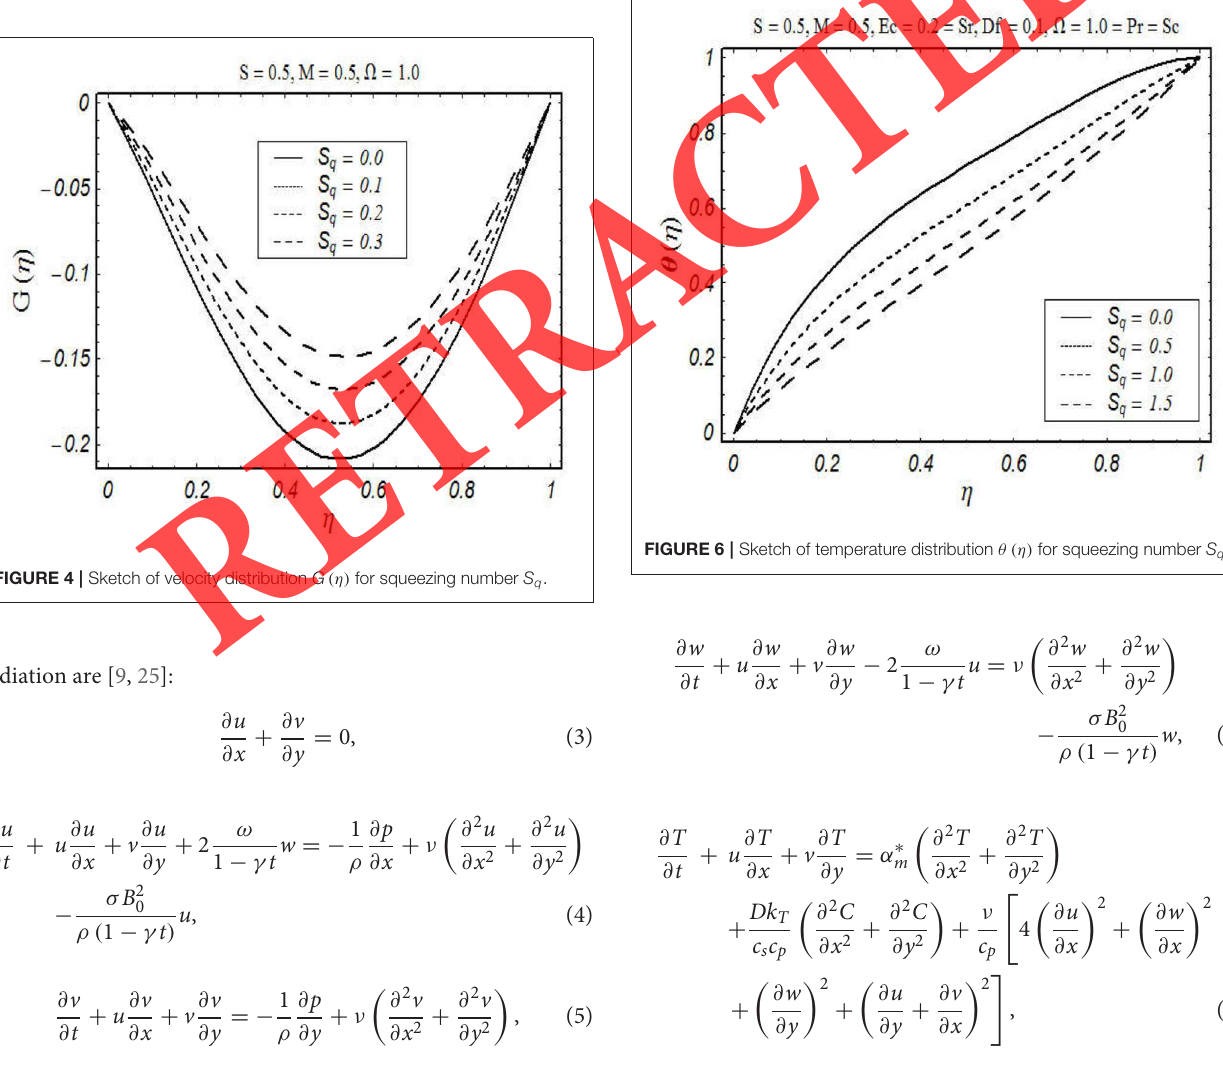
FIGURE 3 | Sketch of velocity distribution F ′ (η) for magnetic number M .